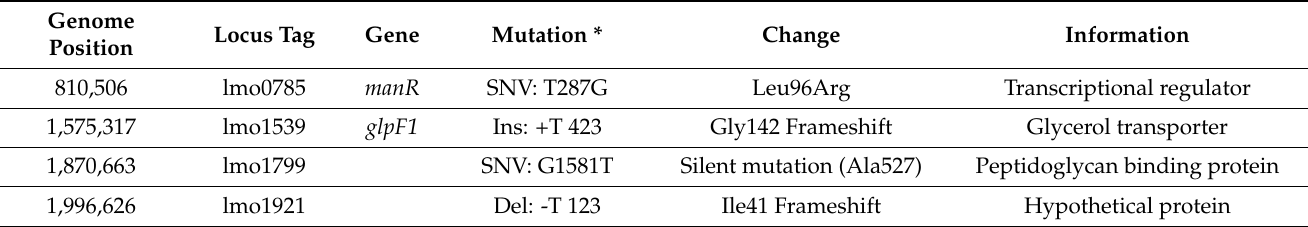
Table 4. Mutations of LmLCar (evolved by cyclic exposure to short lethal treatments of carvacrol) in comparison with LmWT, verified by Sanger sequencing. SNV: Single nucleotide variation, Ins: insertion, and Del: